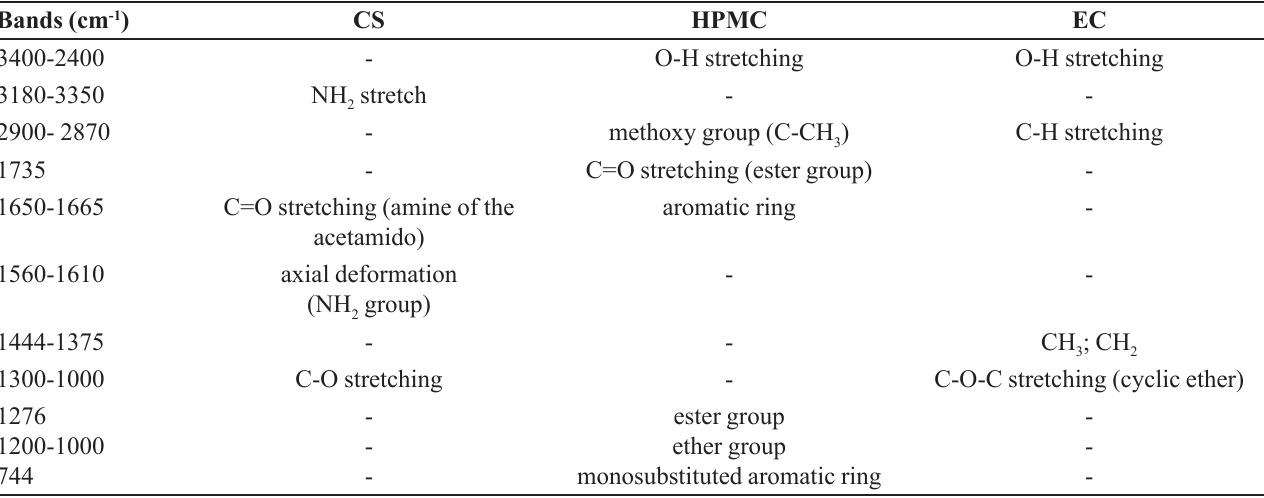
TABLE III - Characteristics bands of used polymers composing the floating microparticles